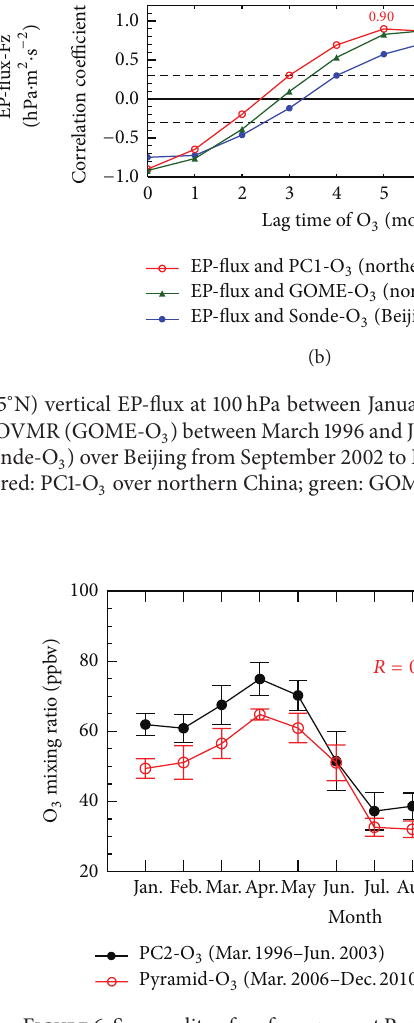
Figure 6: Seasonality of surfaceozone at Pyramidstation (Pyramid- O 3 ) from March 2006 to December 2010 and the regional mean (within ± 1 ∘ , centered at Pyramid station) PC2 decomposed from GOME TOVMR (PC2-O 3 ) between March 1996 and June 2003. Error bars are standard deviations ( ±𝜎